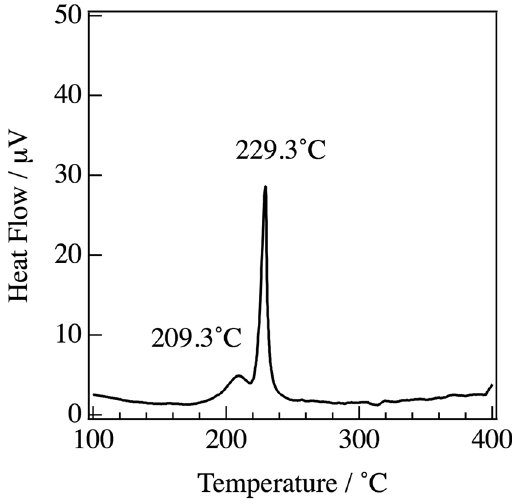
Figure 1. DTA curve for the 75Li 2 S-25P 2 S 5